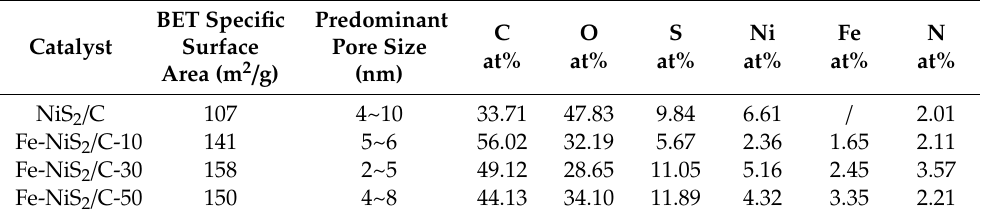
Table 1. The contents of di ff erent nitrogen doping configurations for the samples are listed in Table S1. Table 1. Summary of the BET specific surface area, pore size and surface compositions of catalysts determined by